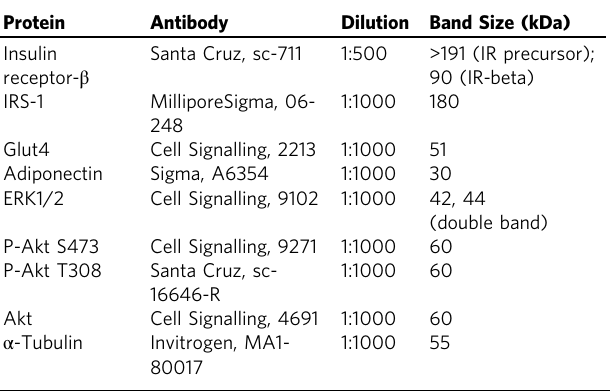
Table 3 Antibodies used for Western